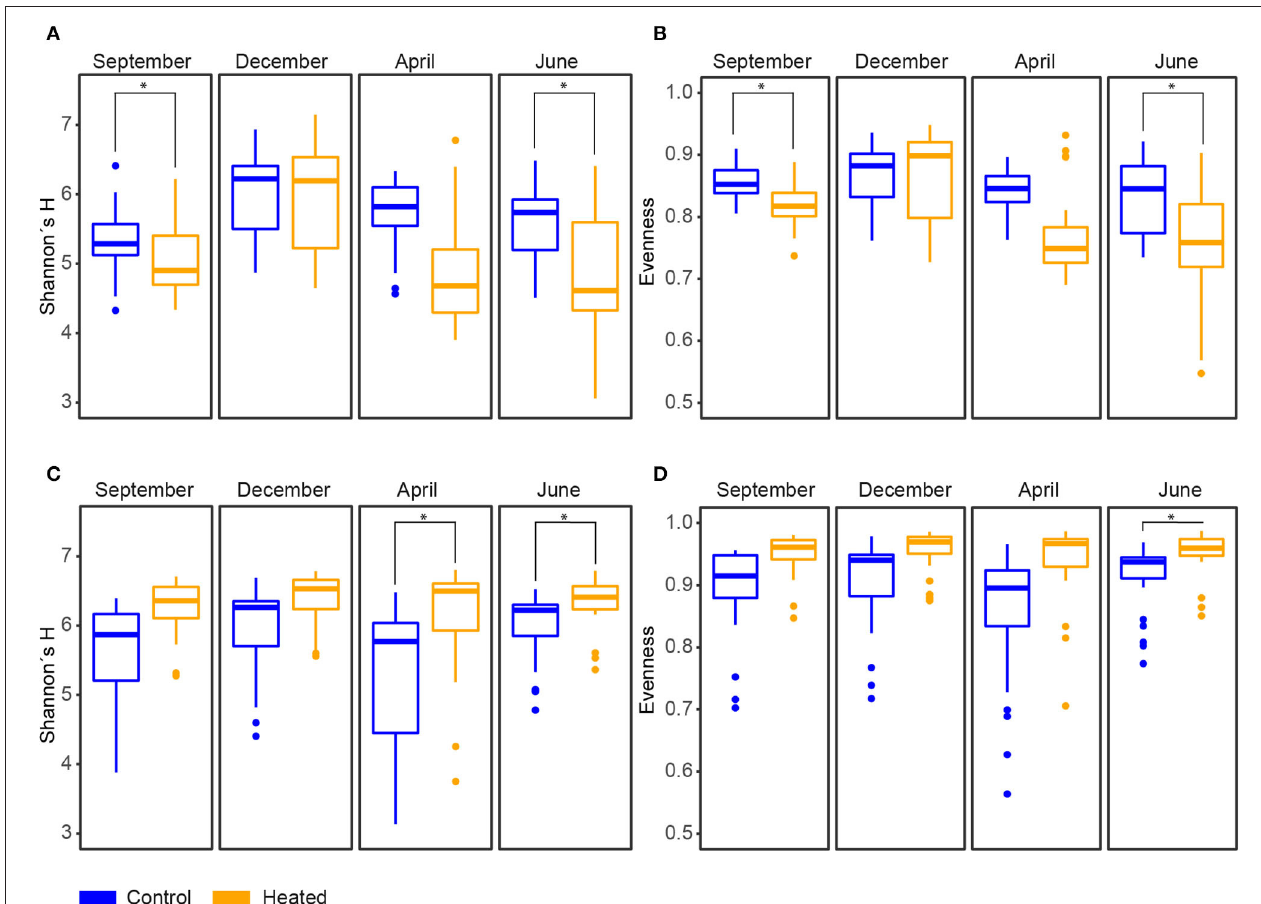
FIGURE 3 | Diversity of microbial communities in bottom water and sediment over different seasons in the heated and control bays. Heated (orange) and control (blue) bay diversity indices for the four sampling occasions between September 2017–June 2018 (all n = 191), showing (A) Shannon’s H diversity and (B) evenness based on Shannon’s H diversity index for bottom water samples (sample “X2061” was excluded due to the small amount of reads; Supplementary Table 1 ). (C) Shannon’s H diversity and (D) evenness based on Shannon’s H diversity index for sediment samples (samples “X51” and “X11” were excluded; Supplementary Table 1 ); Significant differences between bays are marked with an